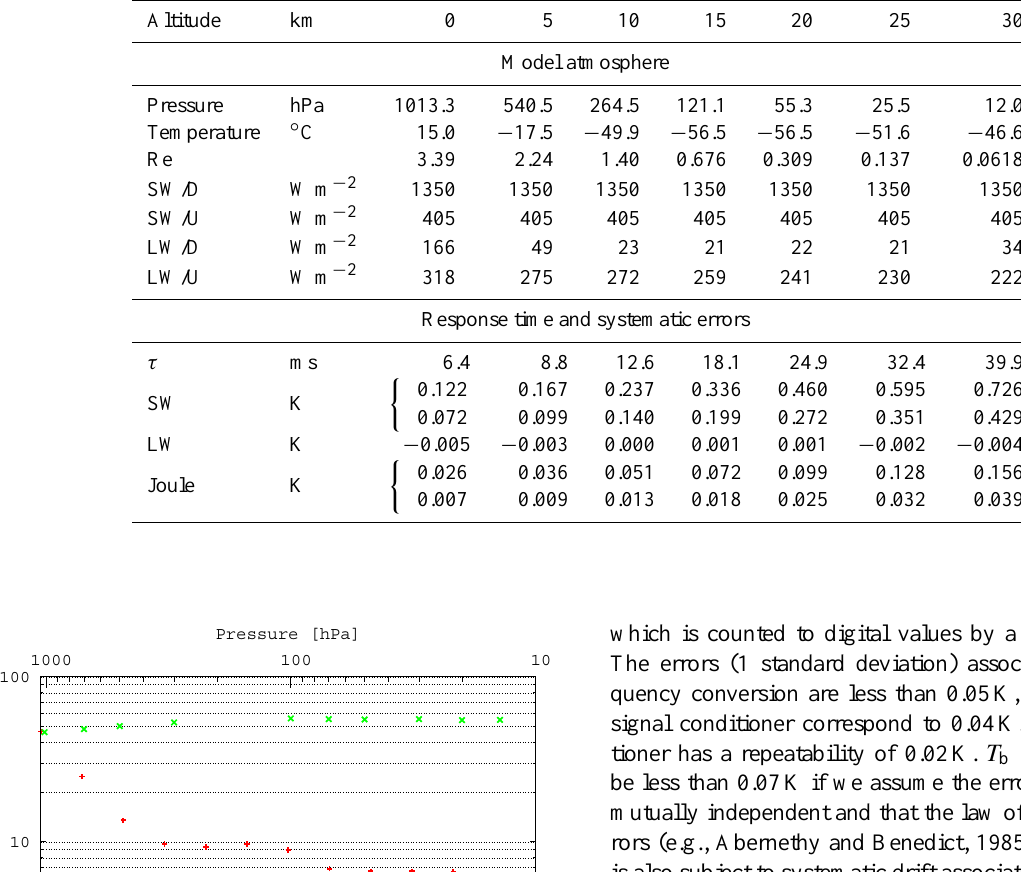
Table 1. Typical values of the time constant (relaxation time; τ ms) of the sensor, systematic errors (K) arising from solar short-wave (SW) and terrestrial long-wave (LW) radiations, and measurement-current induced Joule heating for the virtual sounding in a midlatitude model atmosphere specified in the upper rows. D and U stand for the radiation (Wm − 2 ) in downward and upward, respectively. 5ms − 1 is assumed for the ascending velocity of radiosonde. Those values in the second row in SW and Joule are the specifications after an upgrade of May 2010.